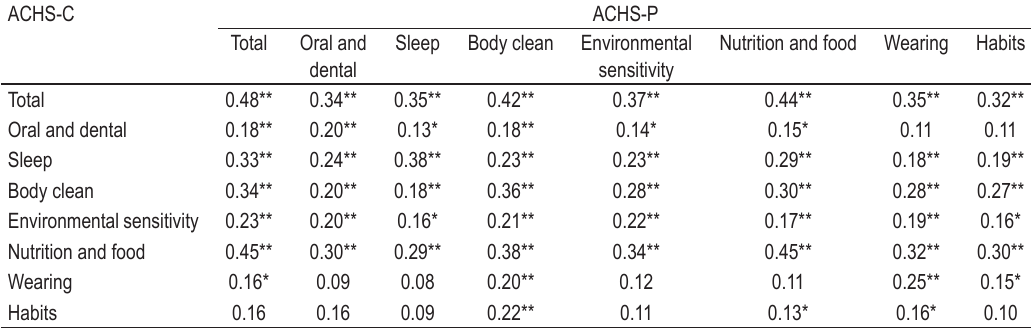
TABLE 6. Correlation matrix of subgroups and total scores for ACHS-P and ACHS-C ACHS-C